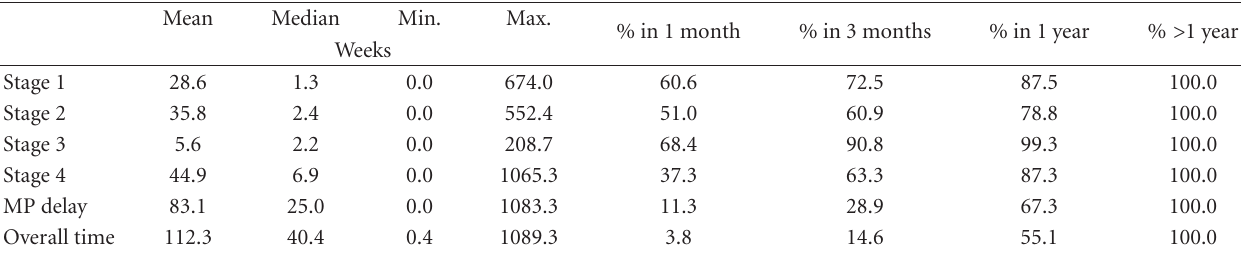
Table 3: Summary of delays.